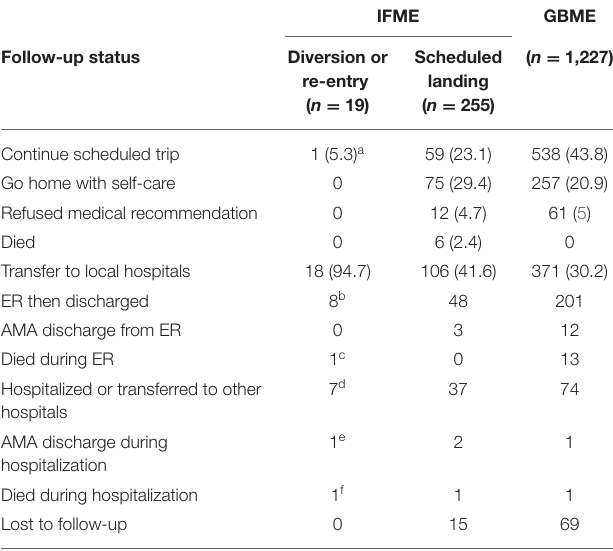
TABLE 3 | Medical recommendation and follow-up given for ground-based or in-flight medical